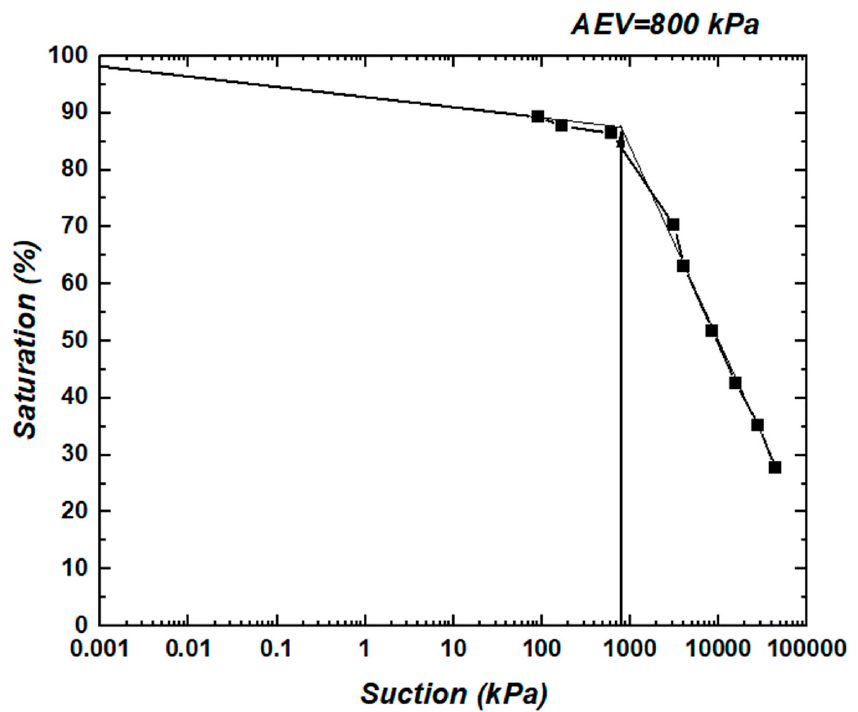
Figure 4. Soil water characteristic curve from the clay at AL-5 based on in-situ measurements of moisture content and suction.